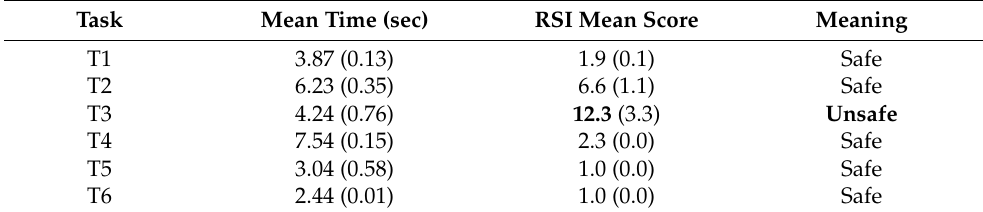
Table 2. Summary of the time study and RSI assessment (bold denotes the major final SI score).